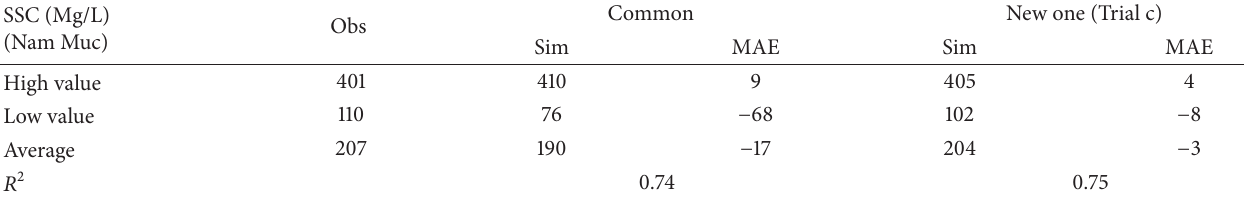
Table 6: Comparison of simulation results from new sediment rating curve and common sediment rating curve in Nam Muc basin.